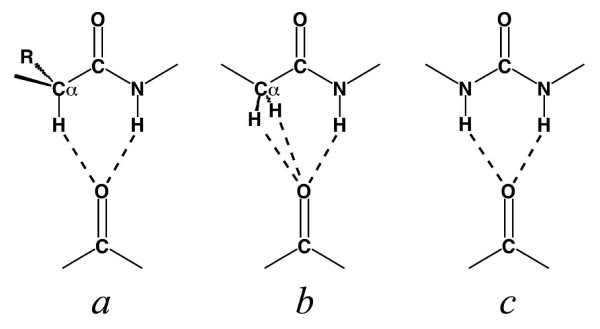
Bifurcated hydrogen bonding topologies. (a) The ubiquitous bifurcated hydrogen bonding topology seen in β-sheets and also in the collagen triple helix. The peptide chain is depicted with the N-terminus to the left. (b) Variation of the same bifurcated topology when the residue N-terminal to the donor N-H group is Gly, as observed in the cRGD-αVβ3 and EFB-αIIbβ3 crystal structures when Gly Hα atoms are built with standard geometry. Either one or two of the Gly Hα atoms can be in hydrogen bonding position. (c) Variation of the same bifurcated topology when the CH2 group N-terminal to the donor N-H group is replaced by another N-H group. This situation occurs for example when Gly is substituted by aza-glycine [37].